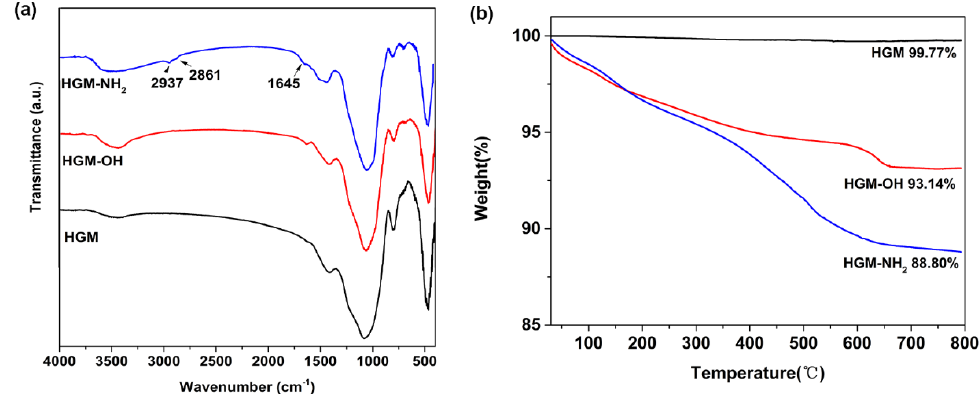
Figure 2. FT-IR spectra ( a ) and TGA curves ( b ) of HGM before and after modification.